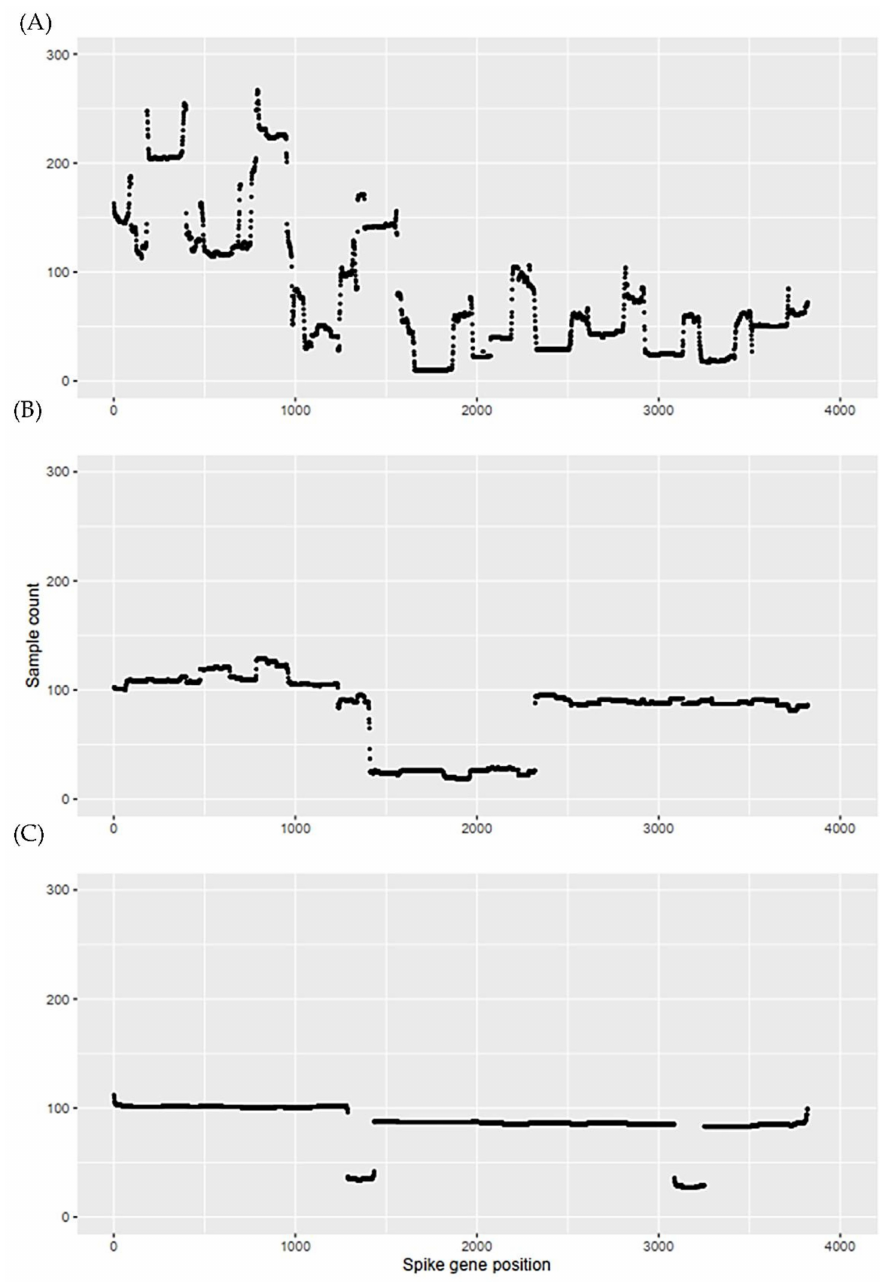
Figure 3. Sample count profiles with sequencing depth <25 across the spike gene. A total of 3000 Nanopore sequencing runs of SARS-CoV-2 samples downloaded from Sequence Read Archive (SRA). One thousand sequencing runs of ( A ) set I with AvgSpotLength < 600 bp; ( B ) set II, 600–1600 bp; and ( C ) set III, ≥ 1600